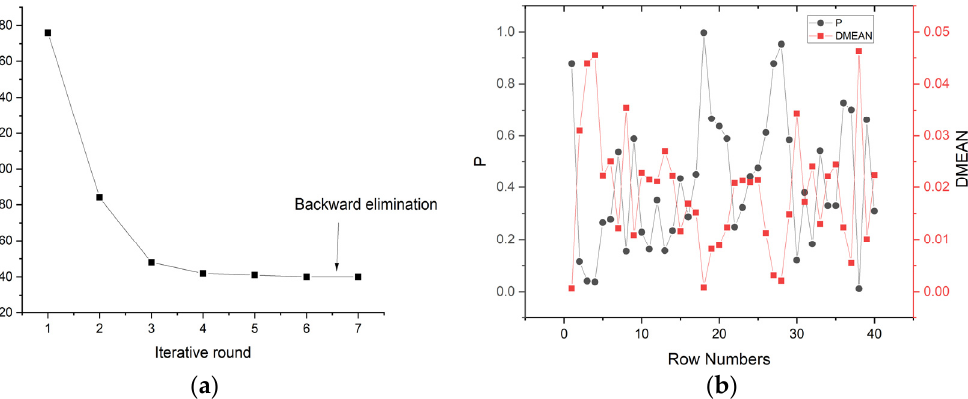
Figure 8. IRIV algorithm selection process: ( a ) The change in the number of retained informative variables in each round; ( b ) Changes in P value and DMEAN in the sixth round.